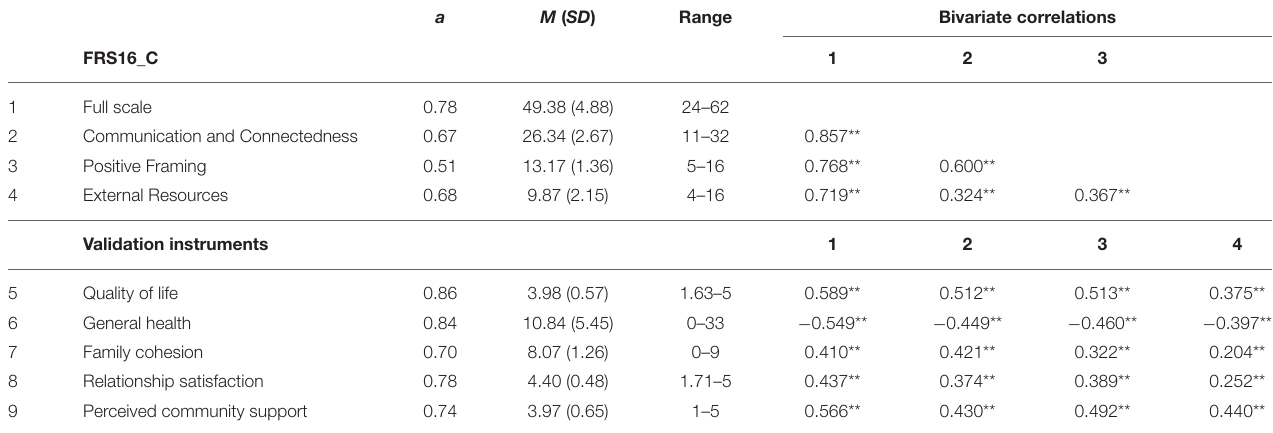
TABLE 6 | Descriptive statistics of main variables (Chinese